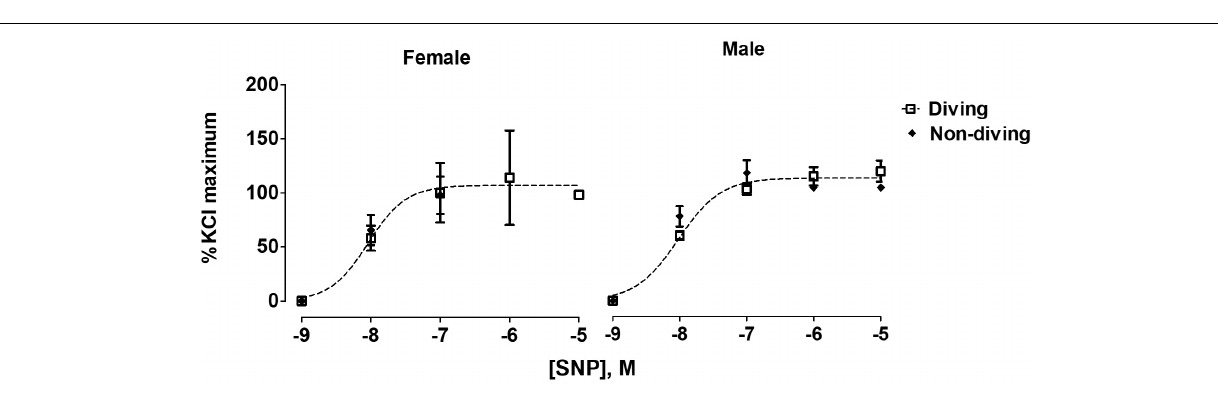
FIGURE 8 | Concentration-response curves for endothelial-independent relaxations to SNP of mesentery arteries of ApoE KO rats from different experimental groups; F test, n =